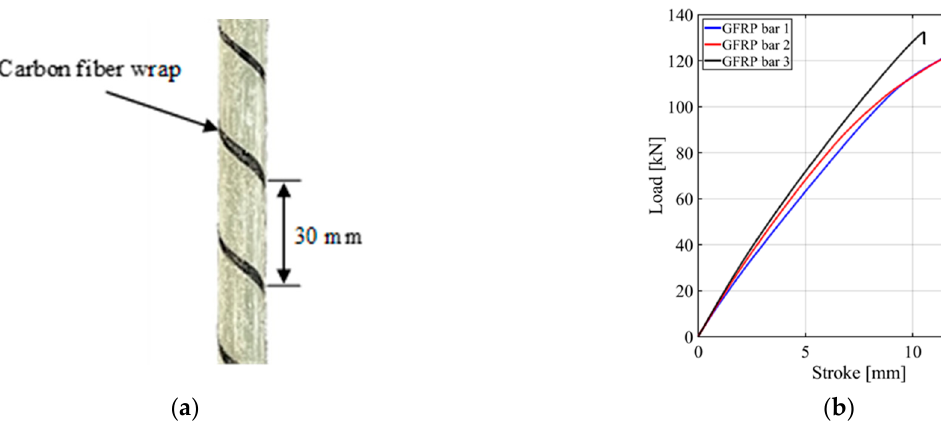
Figure 2. Materials for the test campaign: ( a ) Photo of a segment of the GFRP bar showing the spirally wrapped carbon yarn; ( b ) Tensile test results of GFRP bars.